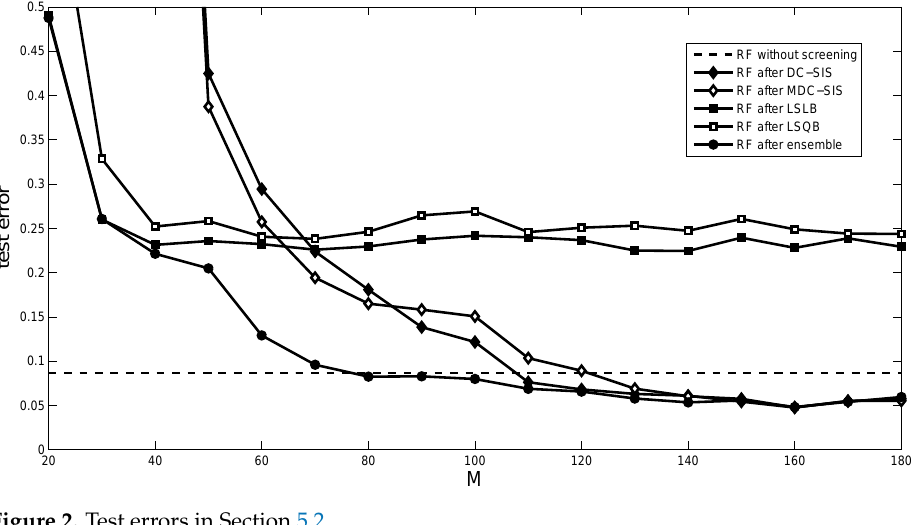
Figure 2. Test errors in Section